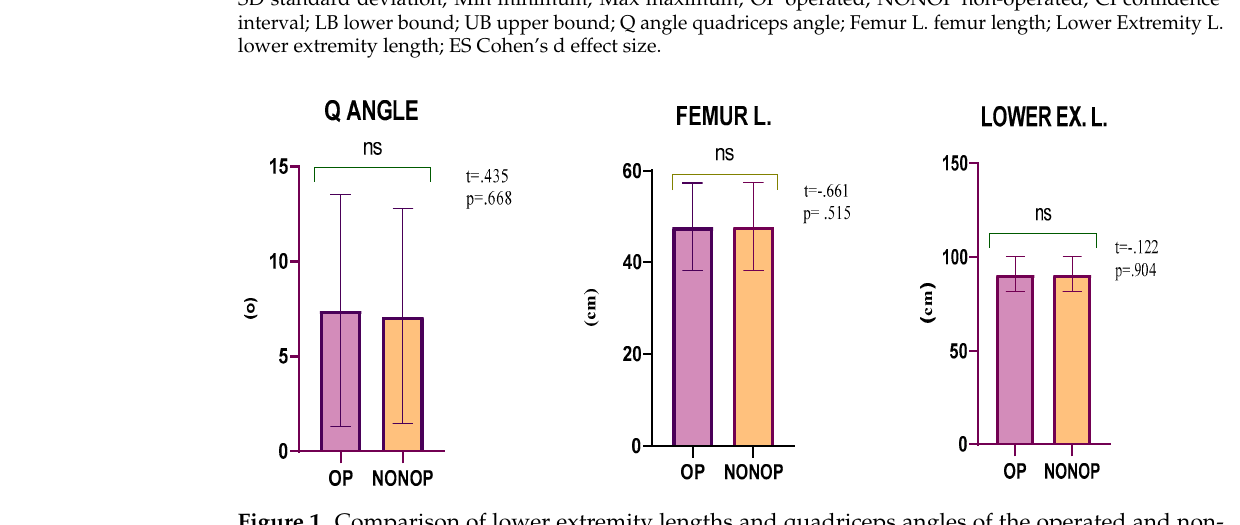
Figure 1. Comparison of lower extremity lengths and quadriceps angles of the operated and non- operated sides.